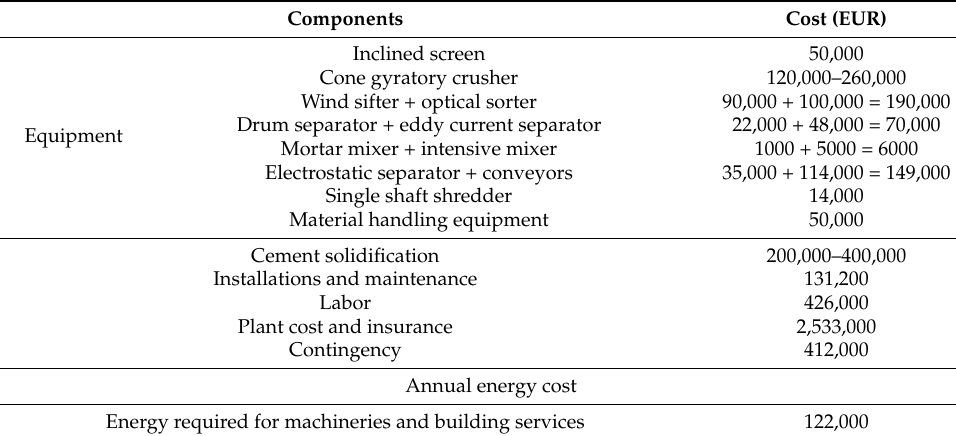
Table 6. Annual investment cost for combined line